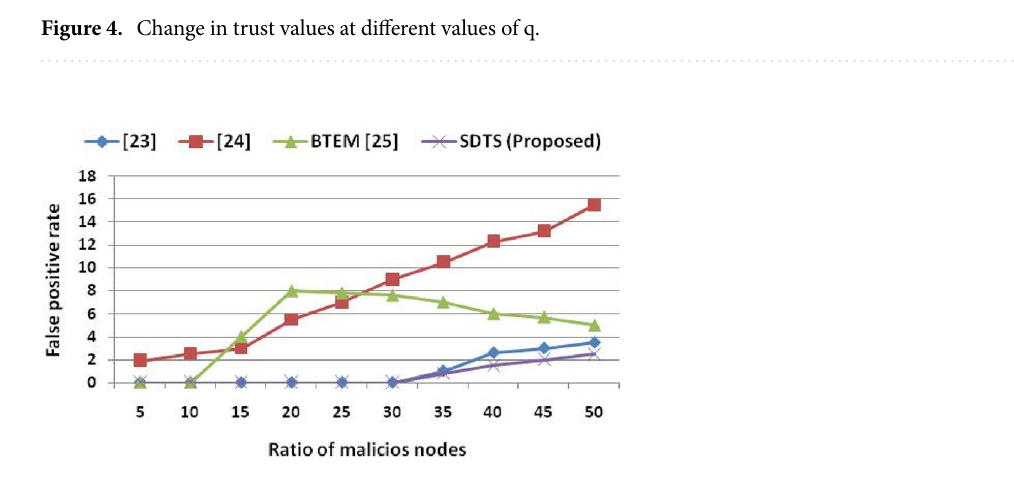
Figure 5. Ratio of malicious nodes vs. false-positive